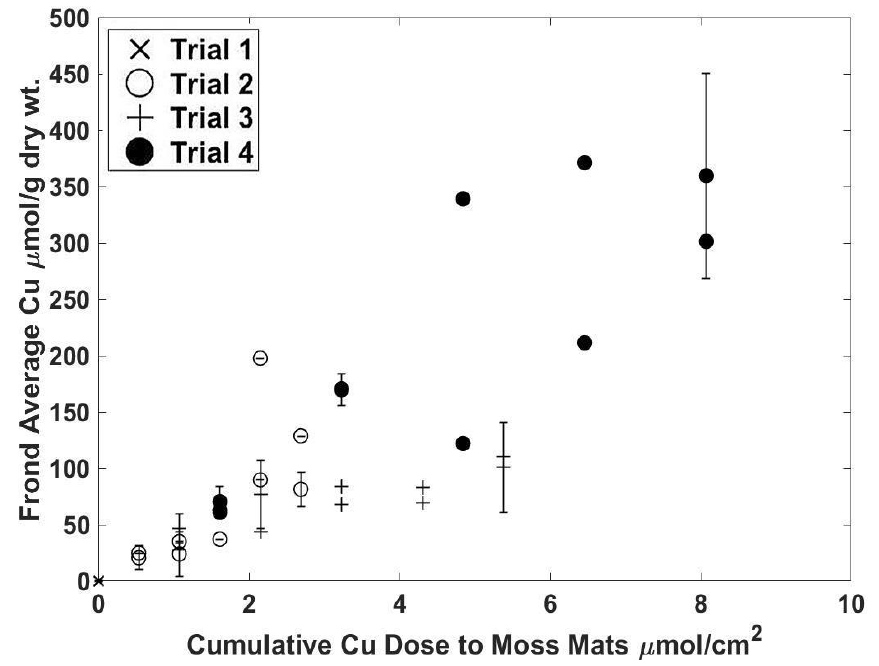
Figure 3. Comparison of the cumulative Cu dose (μmol/cm 2 ) applied throughout the experiment to moss masses against the Cu content found in moss fronds ( µ mol/g dry wt). Error bars represent 1 standard deviation of the average of 3 frond pairs; these are only available for samples collected on days 1, 3, and 10 and provide a measure of scatter of Cu application within the mass moss. For samples where an error bar is absent, a horizontal line may be visible (trial 2) in the center of the marker.